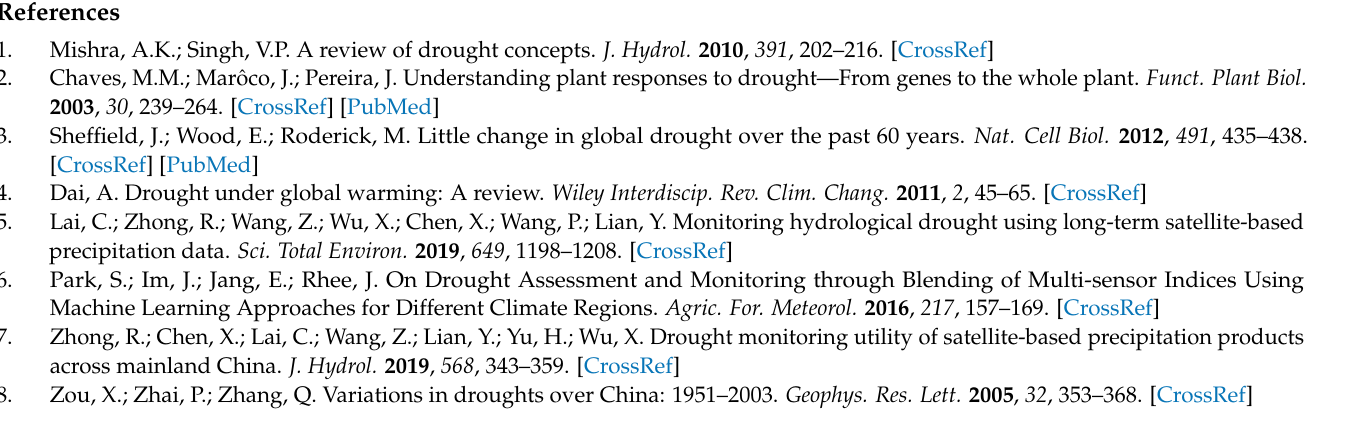
2013, Figure S2: Relationship between LWC and Vcmax25 for various treatments in 2014, Figure S3: Relationship between LWC and Vcmax25 for various treatments in 2015, Table S1: Regression equation between leaf water content and Vcmax25 during